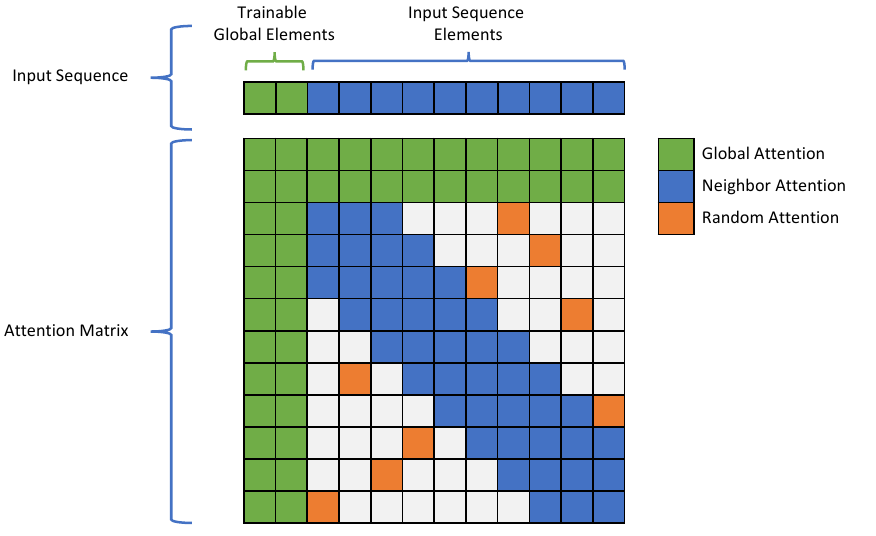
Figure 4. Sparse attention